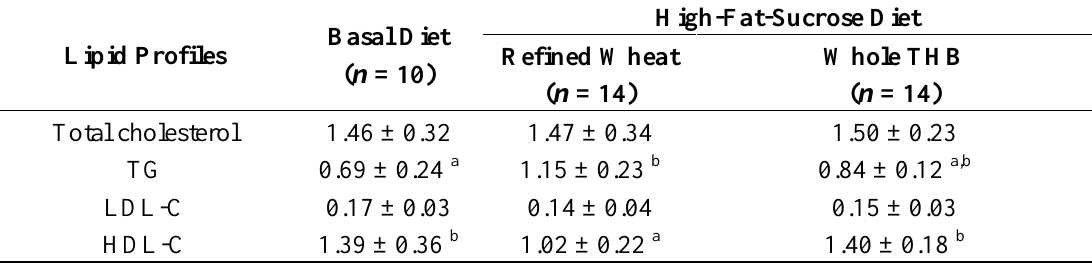
3. Plasma cholesterol, TG, and lipoproteins in rats at the end of the 15-week study